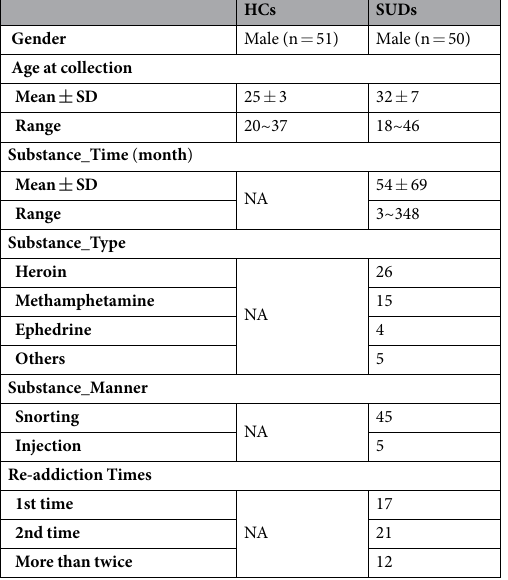
Table 1. Characteristics of 101 Participants. Data are shown as median (interquartile